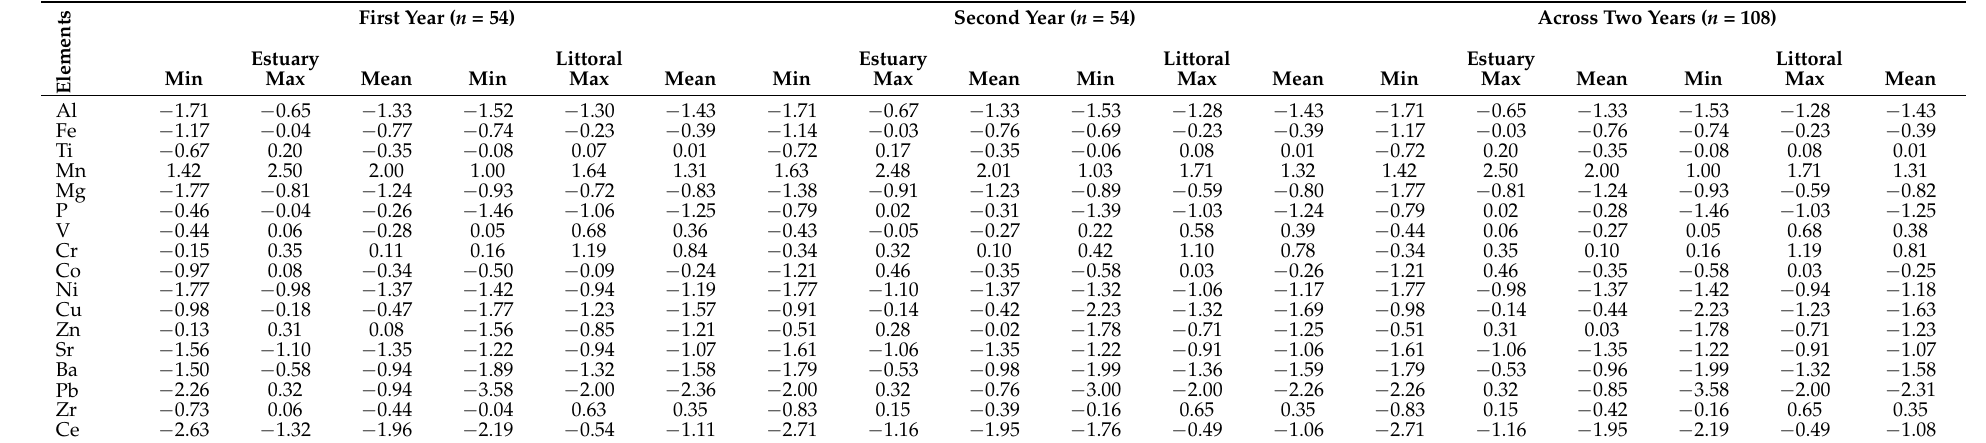
Table 6. The statistical description of geoaccumulation index ( I geo ) in studied sediment samples.